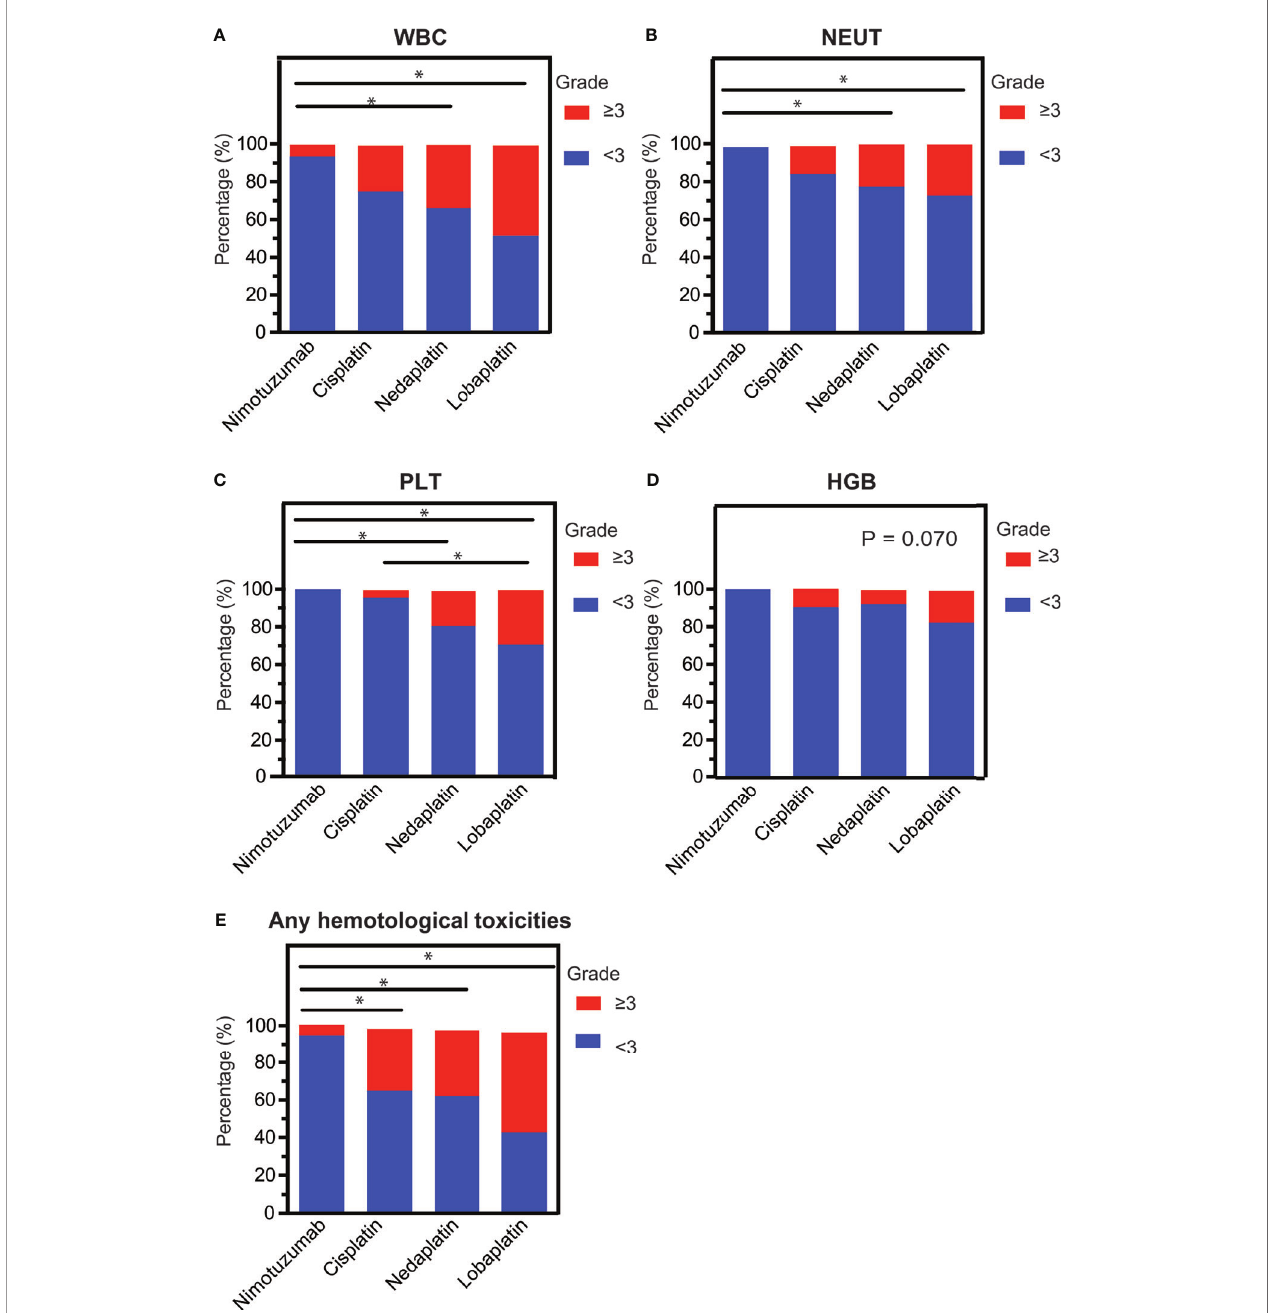
FIGURE 1 | The intra-grade ratios of hematological toxicities. (A) Leukopenia, (B) neutropenia, (C) thrombocytopenia, (D) erythropenia, and (E) any hematological toxicity among LAHNC patients treated with nimotuzumab-, cisplatin-, nedaplatin- and lobaplatin-based concurrent chemoradiotherapy. WBC, white blood cell; NEUT, neutrophil; PTL, platelet; HGB, hemoglobin. *P <